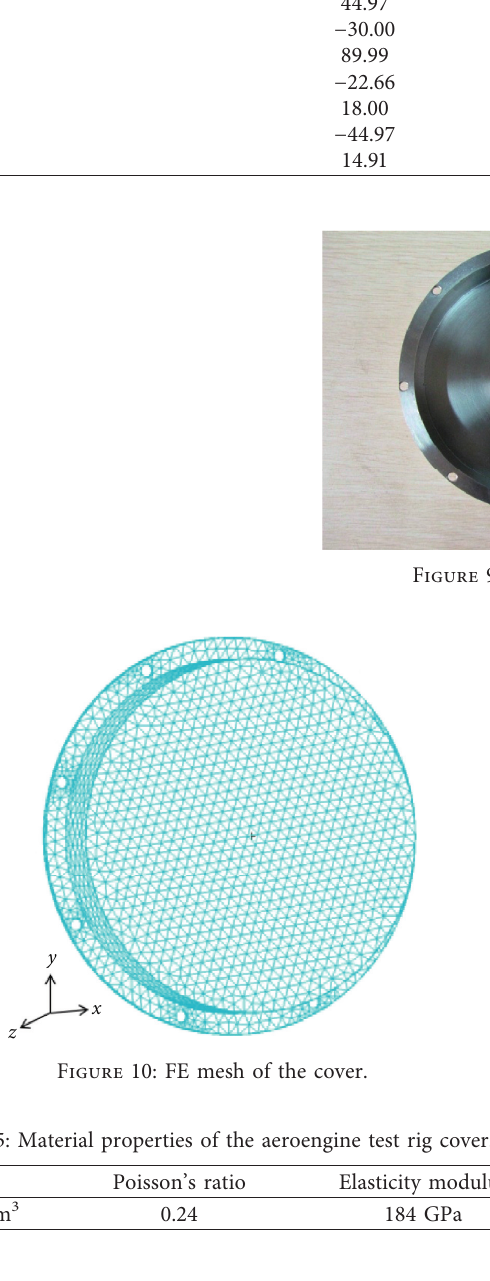
Table 6: Natural frequencies predicted by the FE model of the cover.